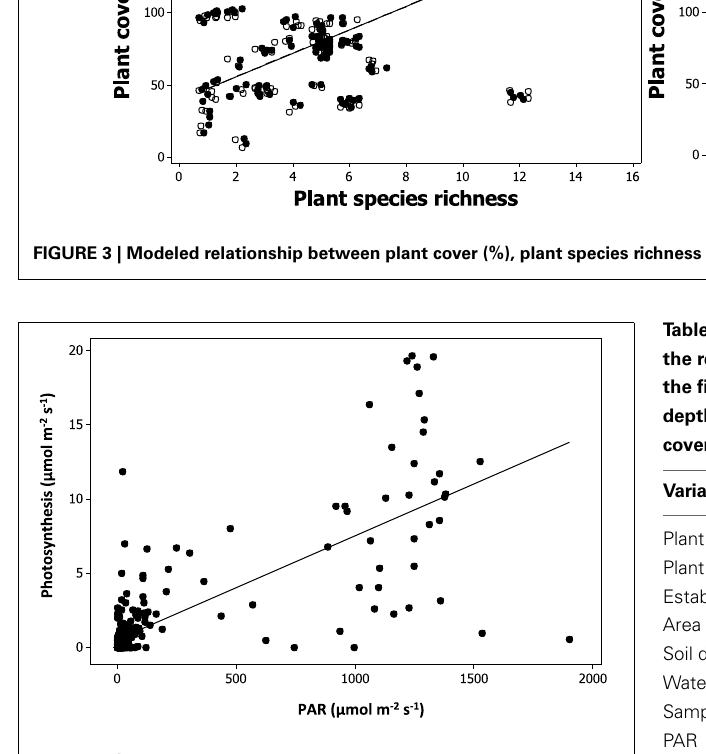
FIGURE 4 | Modeled relationship between plant CO 2 assimilation rates and photosynthetically active radiation (PAR) measurement taken from above of the leaves measured.